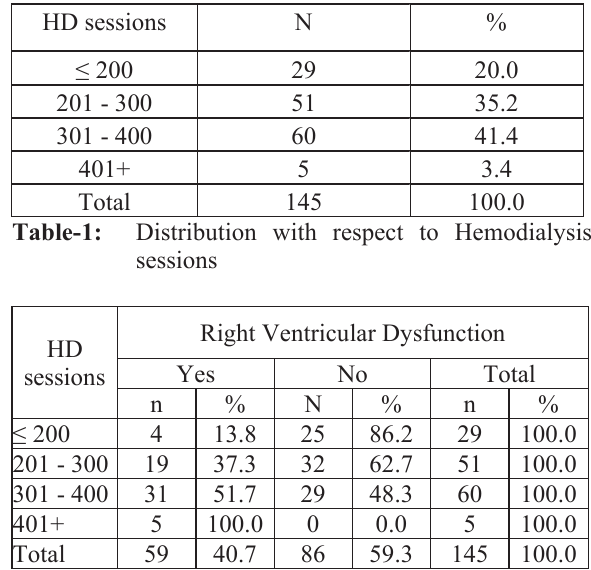
Table-2: Stratification of RVD with Respect to HD